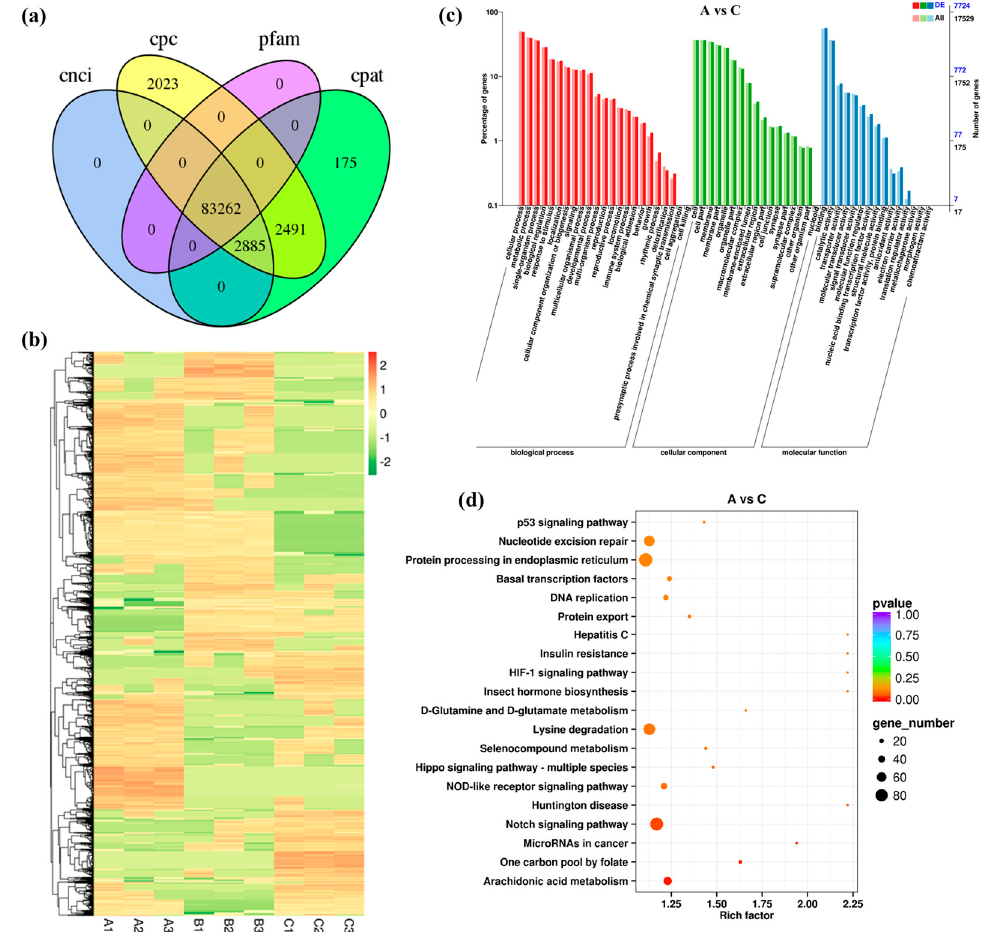
Figure 2. Identification and analysis of DELs under salinity stress. ( a ) Venn diagram showing the number of lncRNAs identified by CNCI, CPC, Pfam, and CPAT methods. ( b ) Heat map of all DELs. ( c ) GO enrichment analysis of DELs in groups A vs. C. ( d ) KEGG enrichment analysis of DELs in groups A vs. C.